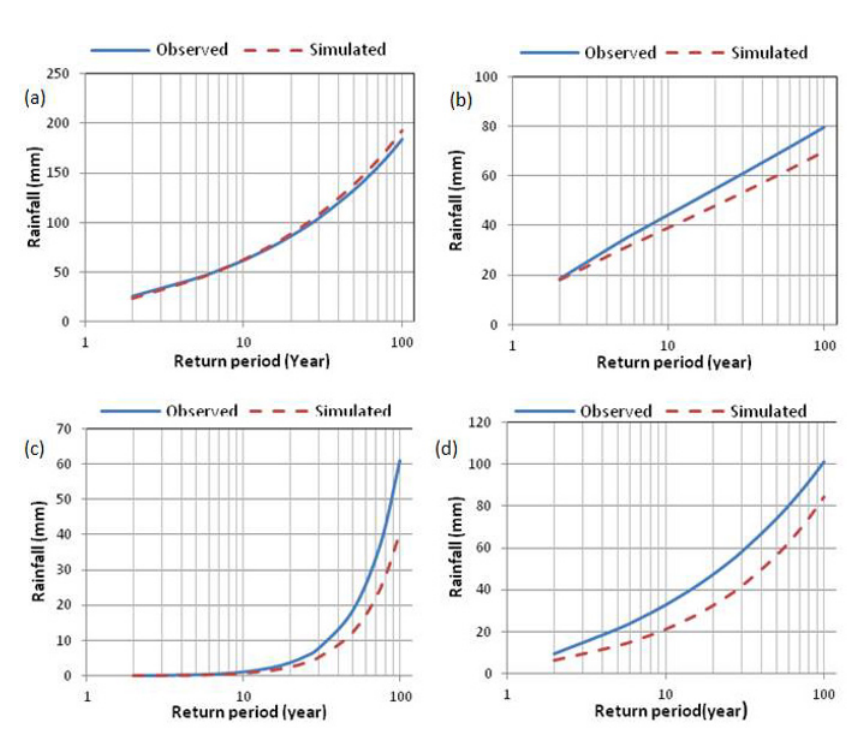
Figure 7. Return period-return level relationship of observed & simulated extremes rainfall for (a) winter (b) spring, (c) summer and (d) autumn during calibration and validation period (1961-2001).